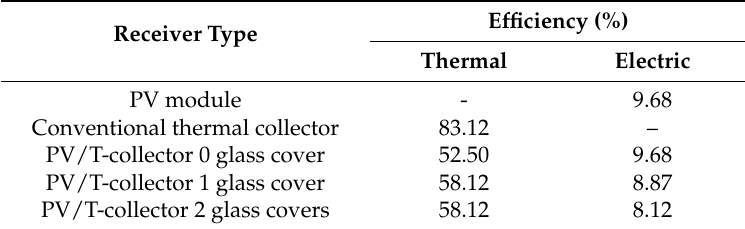
Table 2. Thermal and electrical performance at zero T red ( T amb = T inl ) for different configuration.